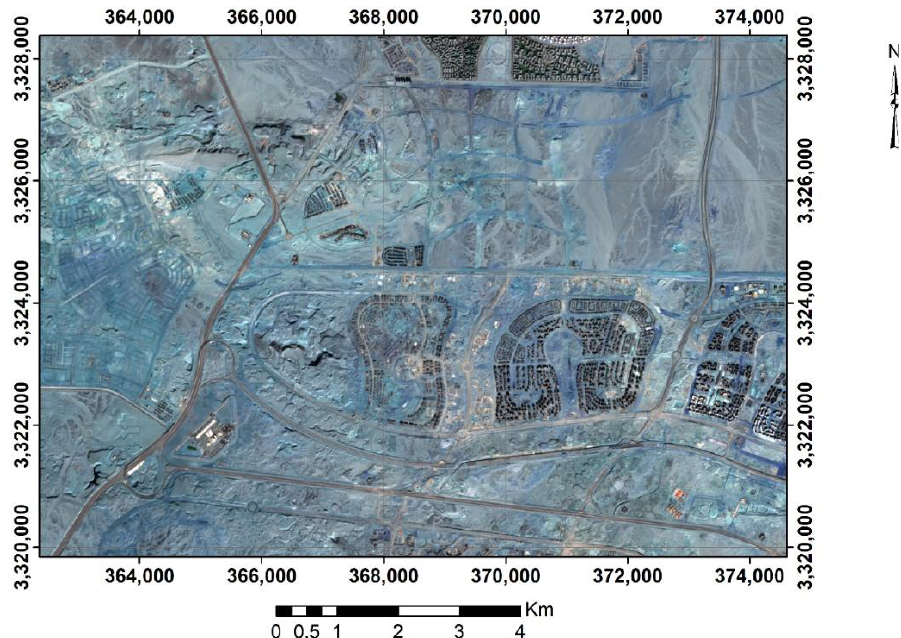
Figure 1. Ten-meter spatial resolution true-color image based on Sentinel-2 satellite data for the study area.